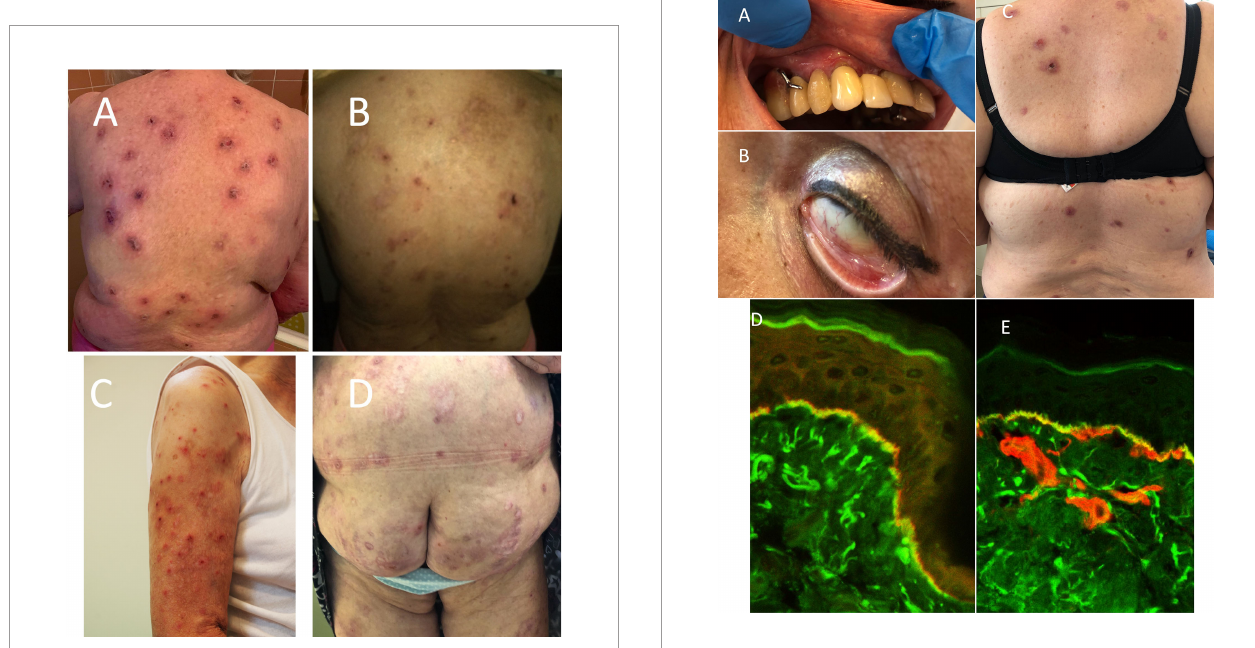
FIGURE 1 | Clinical manifestation of pemphigoid nodularis in the studied patients — disseminated nodules, excoriations, hyperpigmentation, and hypopigmentation in (A) patient 1 (P1), (B) patient 2 (P2), (C) patient 3 (P3), and (D) patient 5 (P5).